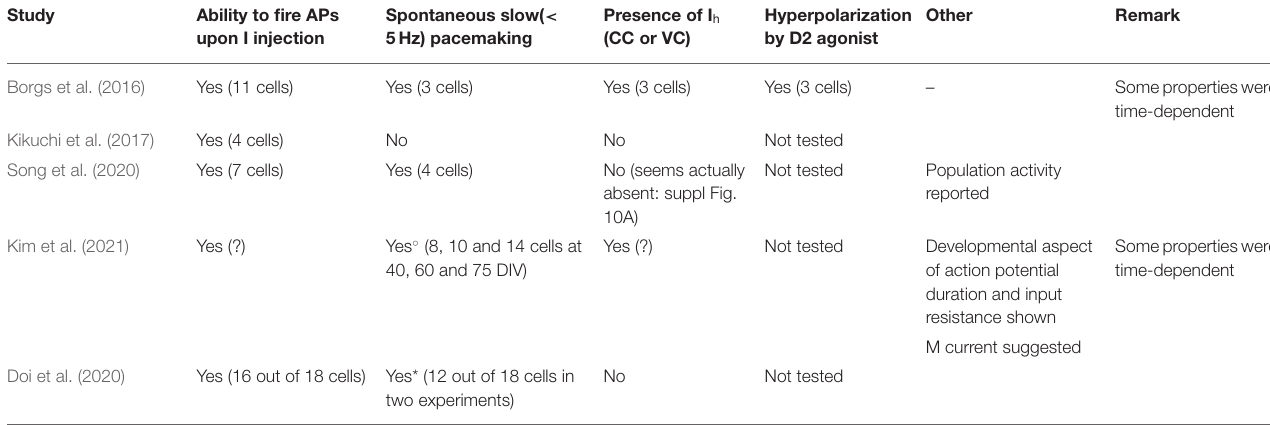
TABLE 1 | Summary of electrophysiological hallmarks of nigral dopaminergic neurons demonstrated to be present in engineered iPS cell-derived human DA cells.